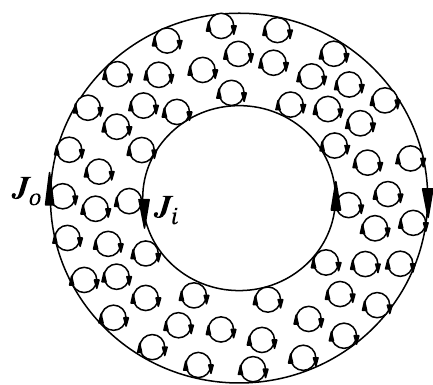
Figure 1. Ampere’s molecular ring current.